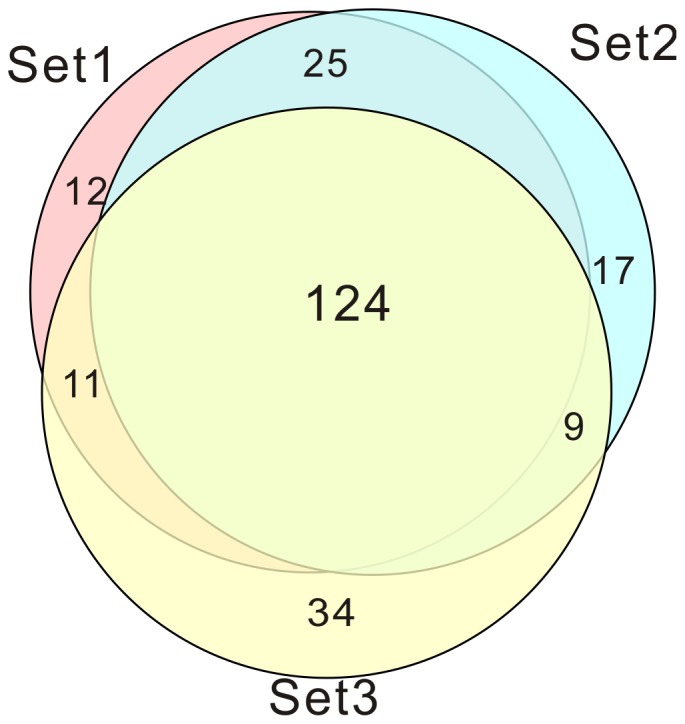
Proteins identified in the three sets (technical replicates).